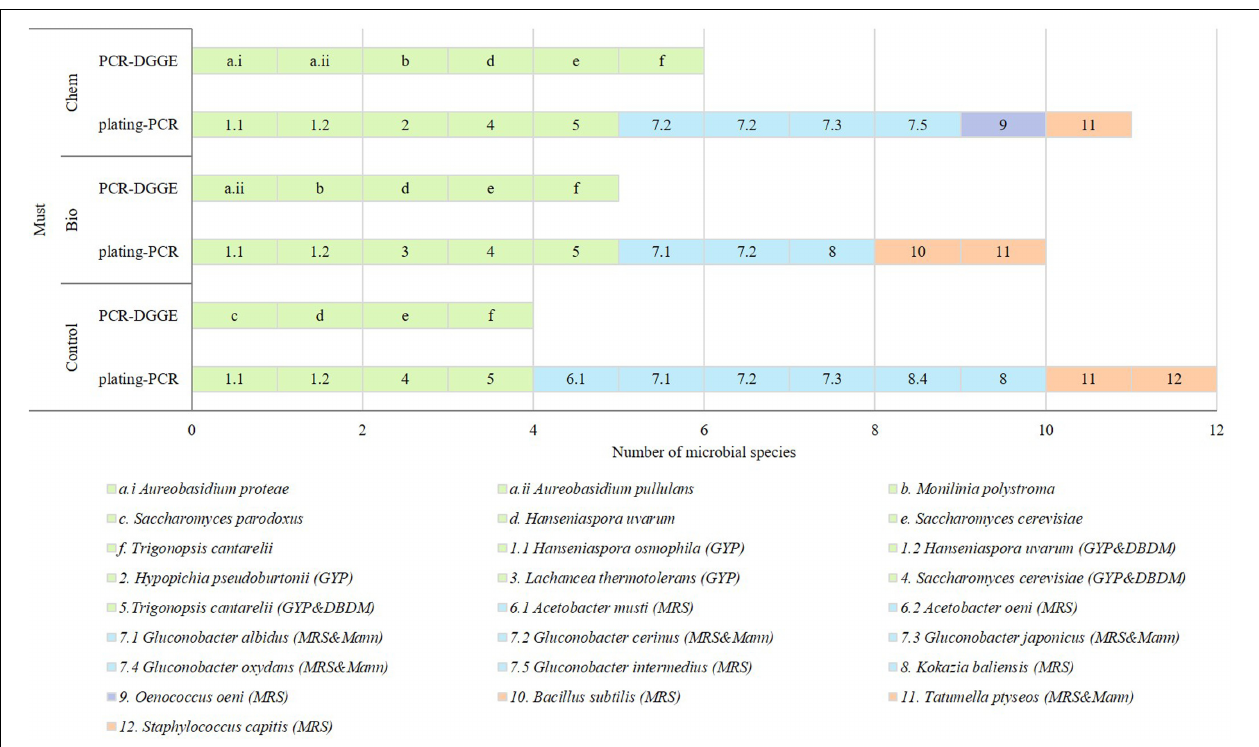
FIGURE 3 | Microbial species detected in must samples (C: control, Bio: bio-fungicide, and Chem: chemical fungicide) from GYP, DBDM, MRS and Mann plates referred to as letters and by PCR-DGGE referred to as numbers. Green slices identified eukaryotic species; blue slices were AAB; purple slices were LAB; and orange slices